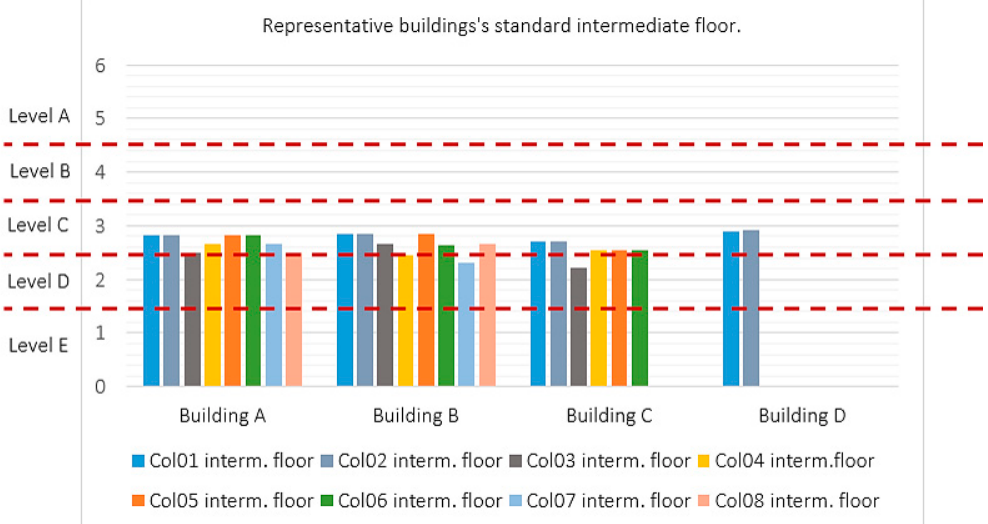
Figure 8. Final classification of the HU (standard intermediate floor) with the water heating system.